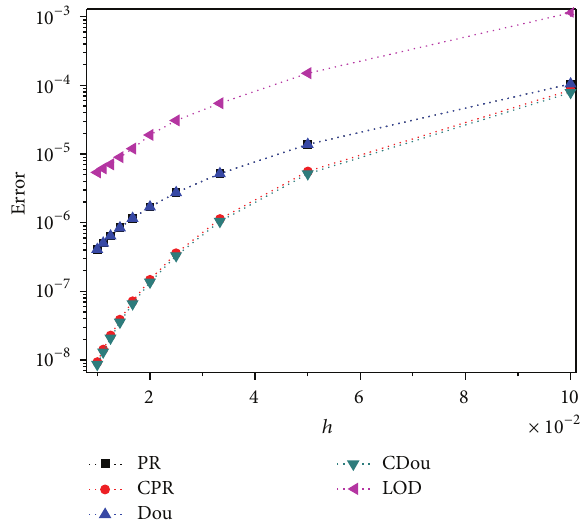
Figure 1: The error of all schemes for various grid sizes when Δ𝑡 = ℎ 2 .